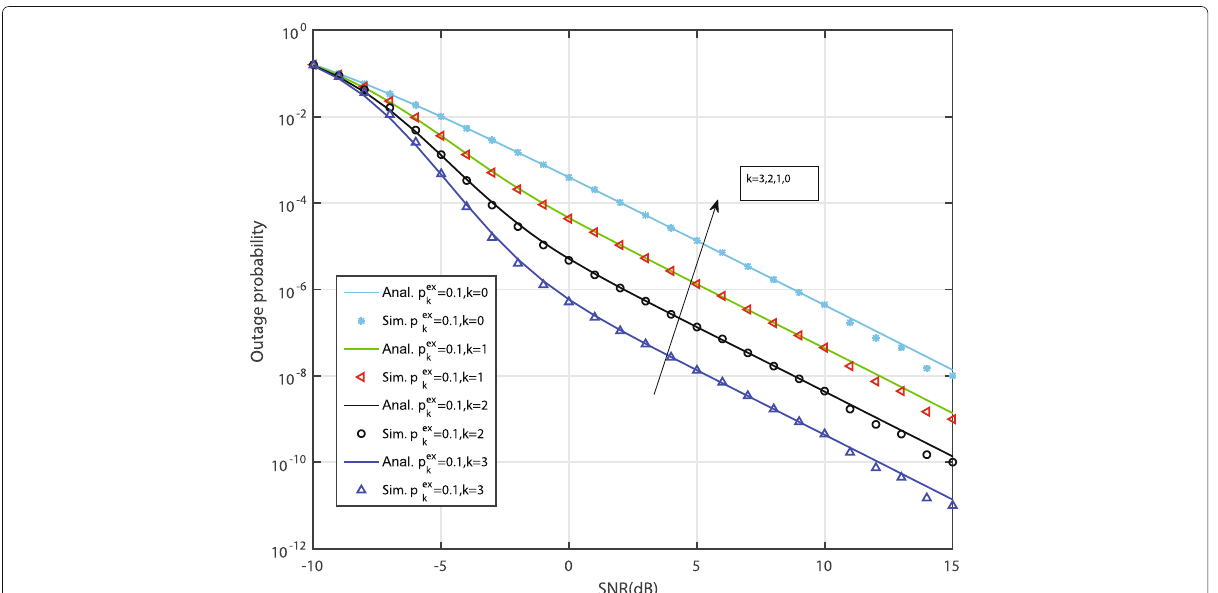
(cid:15) (cid:14) = 0.1, and = 3, m = 3, p ex 1 , p ex 2 ... p ex r k d N r k